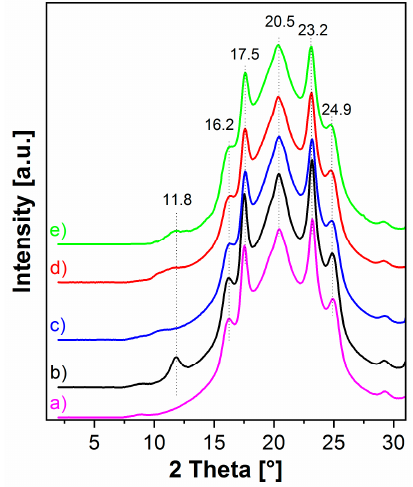
Figure 4. TEM images of PBAT nanocomposites containing 5 wt % of ( a ) pristine LDH, ( b ) LDH-phosphate, ( c ) LDH-decanoate, and ( d ) LDH-phosphinate.